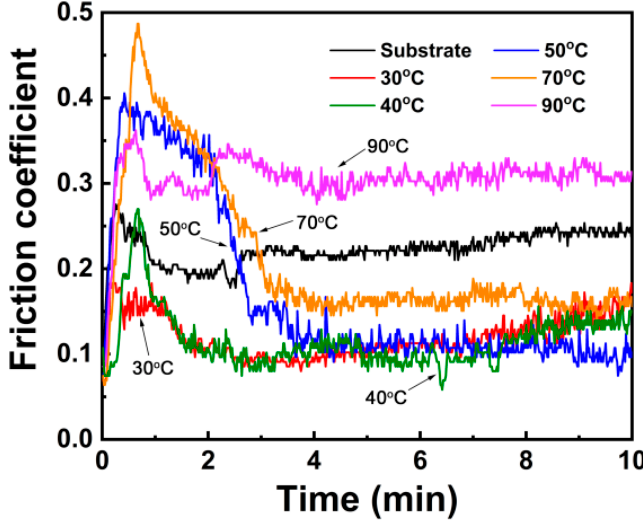
Figure 7. Friction coe ffi cient plotted as a function of sliding friction time of various samples.